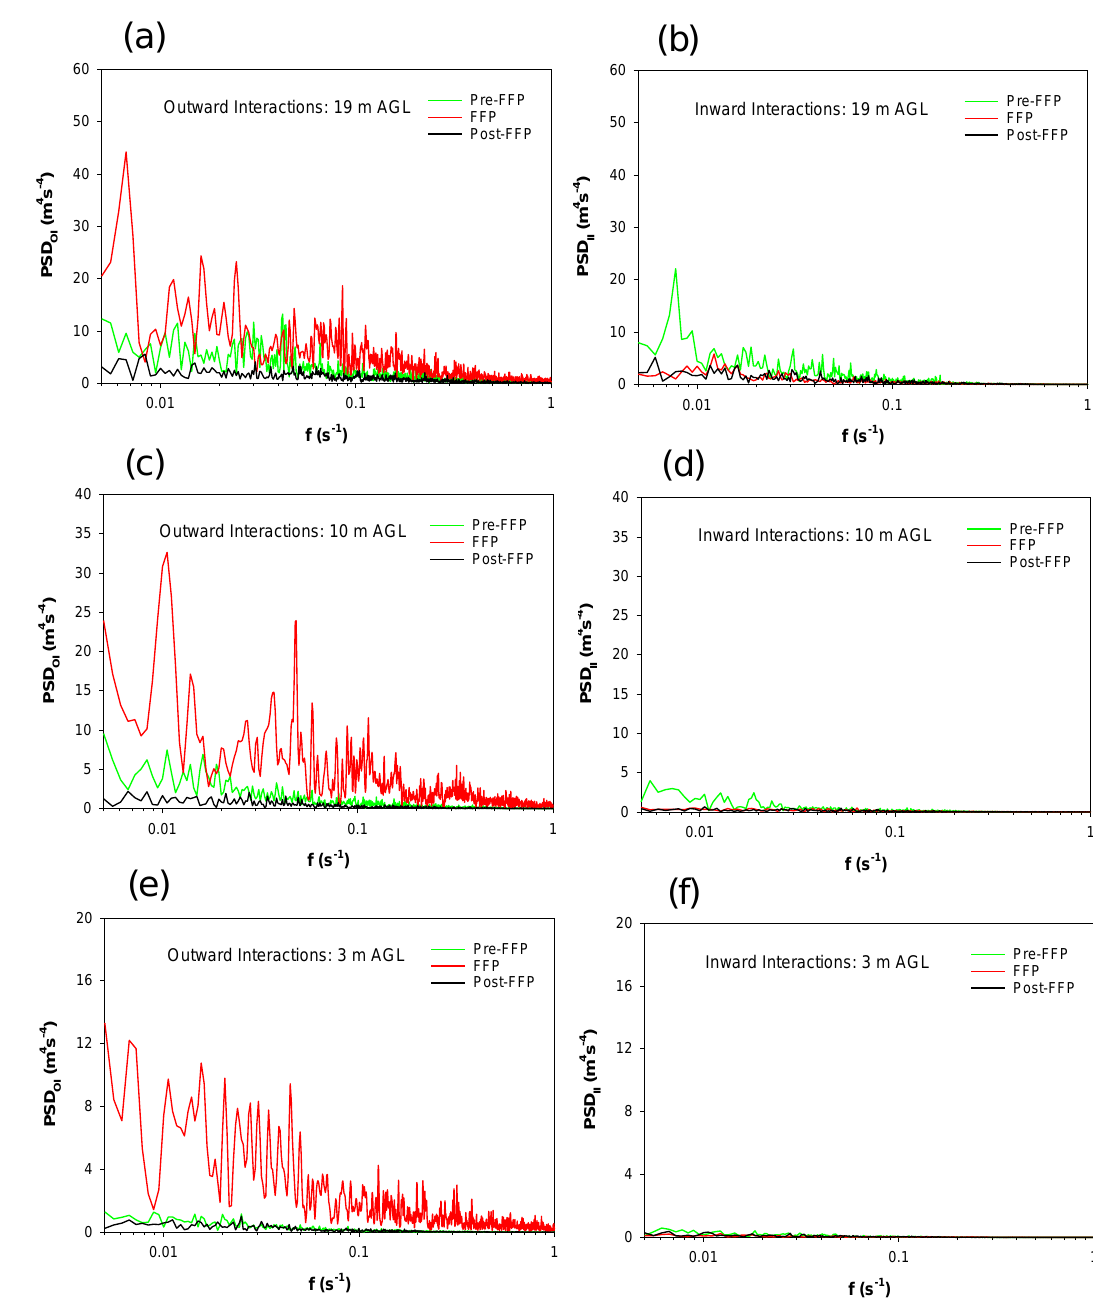
Figure 11. Mean power spectral density (PSD: m 4 s − 4 ) vs. frequency (f: s − 1 ) curves for the positive vertical momentum flux contributors of ( a , c , e ) outward interactions (PSD OI ) and ( b , d , f ) inward interactions (PSD II ) at the 19-m (top row), 10-m (middle row), and 3-m (bottom row) levels for the pre-FFP, FFP, and post-FFP periods, computed from all five in situ